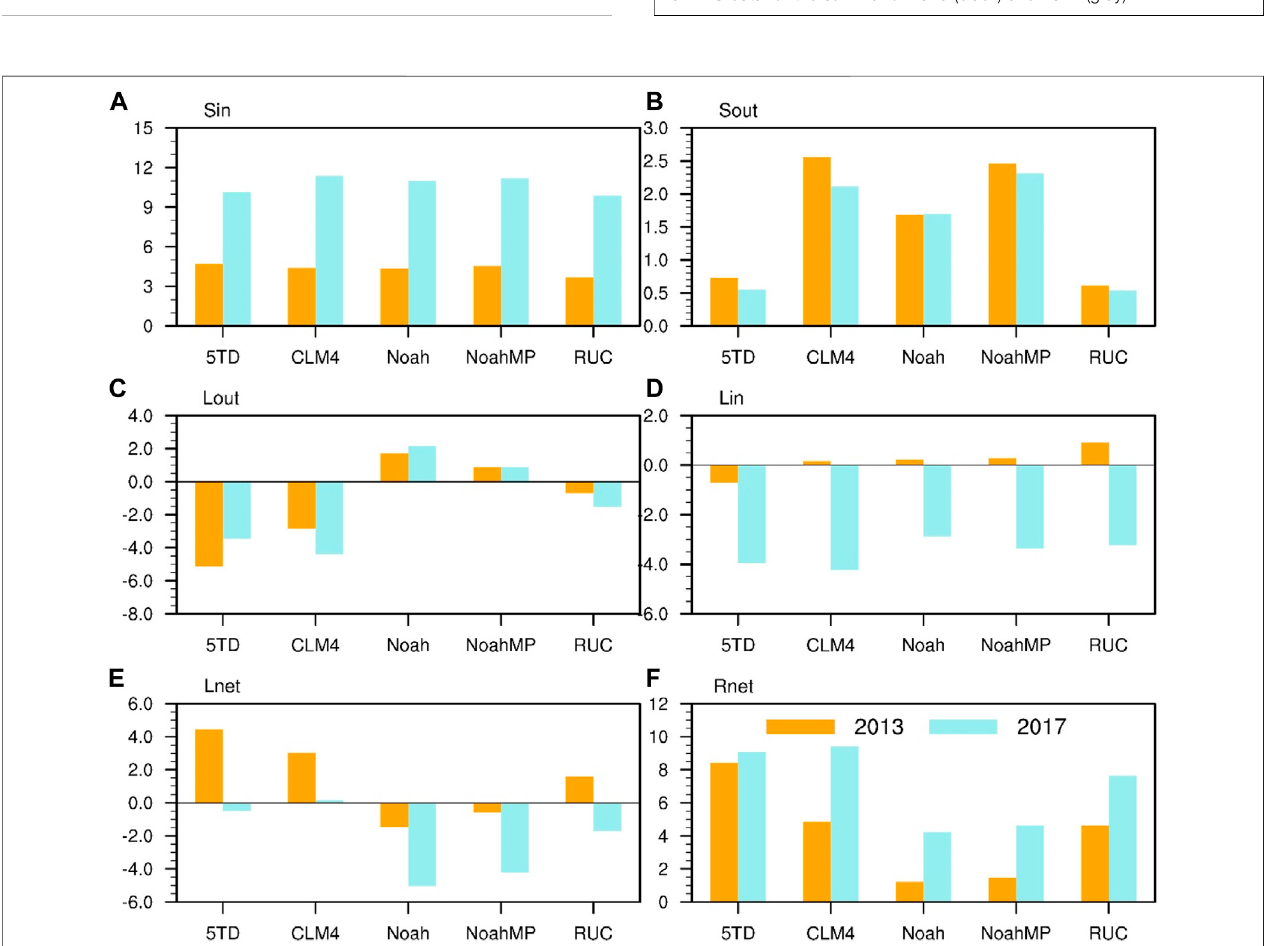
FIGURE 5 | The differences in areal mean surface energy fl uxes (W m − 2 ) over the study region (outlined boxes in Figure 2A ) between the model simulations and CERES data for the summer of 2013 (yellow) and 2017 (blue) for (A) downward shortwave radiation (S in ), (B) upward shortwave radiation (S out ), (C) upward longwave radiation (L out ), (D) downward longwave radiation (L in ), (E) net longwave radiation (L net ), and (F) net radiation (R net ).